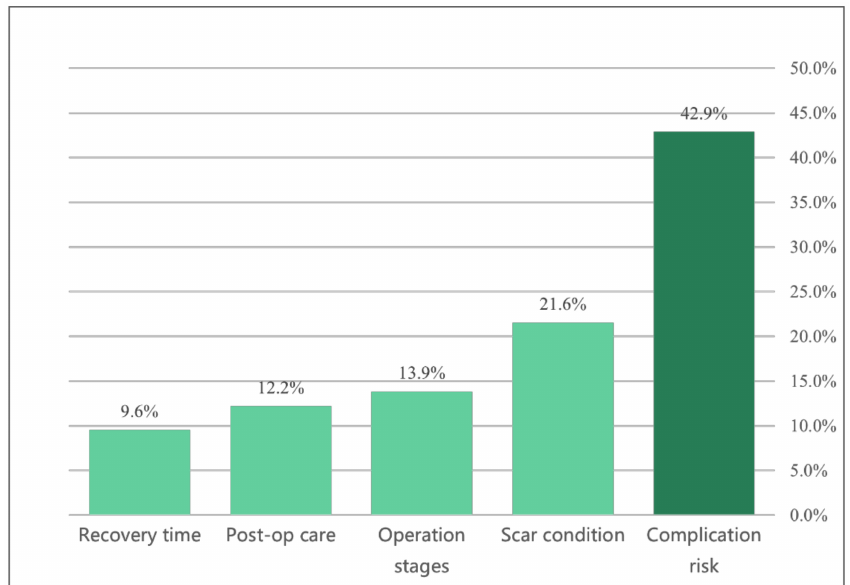
Figure 3. Relative importance of the five attributes of finger reconstruction surgery, scaled to the sum of 100%. The values listed are representative of the average values across participants.